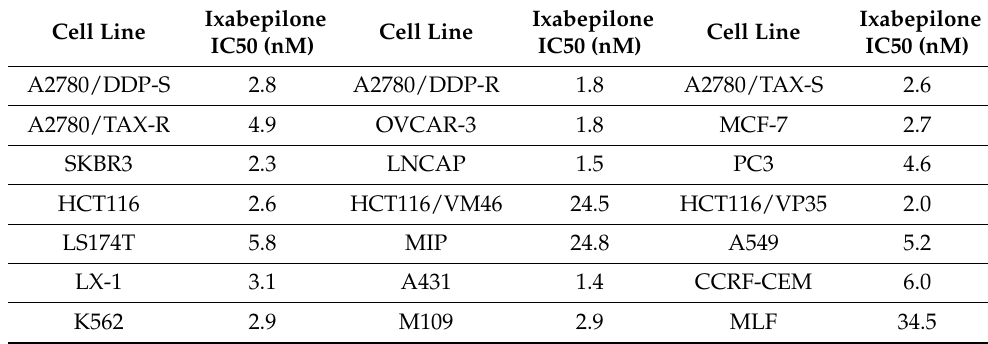
Table 3. Cytotoxicity of ixabepilone against 21 tumor cell